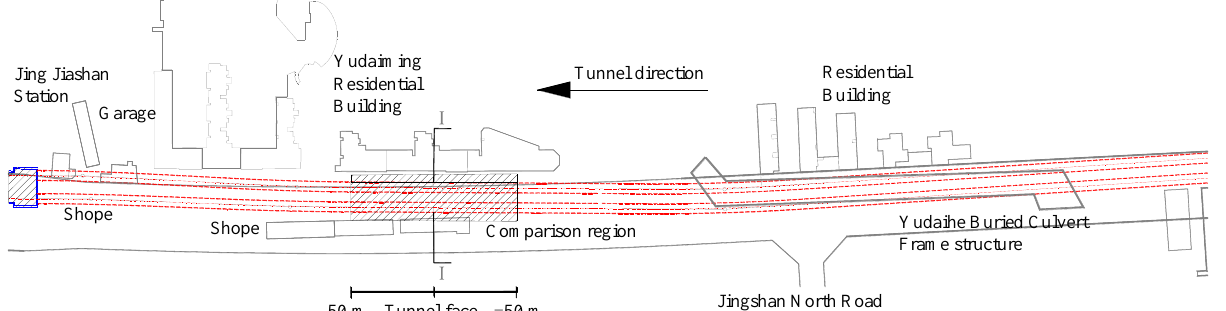
Figure 6. A partial plan view of Jing Jiashan-Shi Zijie section of Nanchang Subway Line 3.